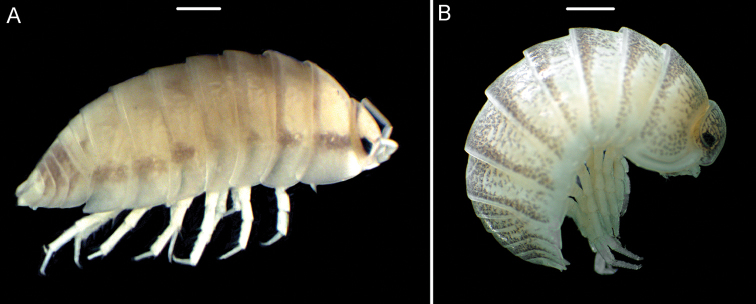
APeriscyphisvittatusBKoweitoniscustamei. Scale bar: 1 mm.